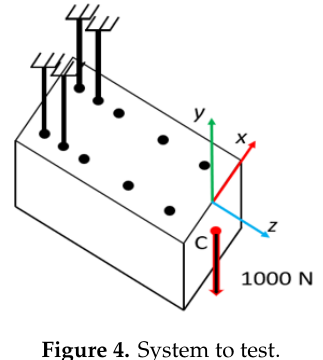
Figure 4. System to test.